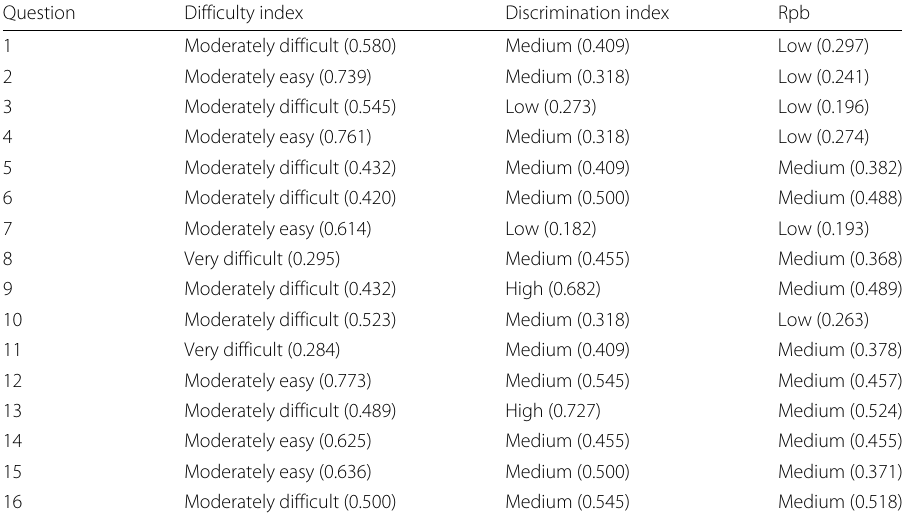
Table 14 Questions’ analysis in test-two (number of students’ attempts =